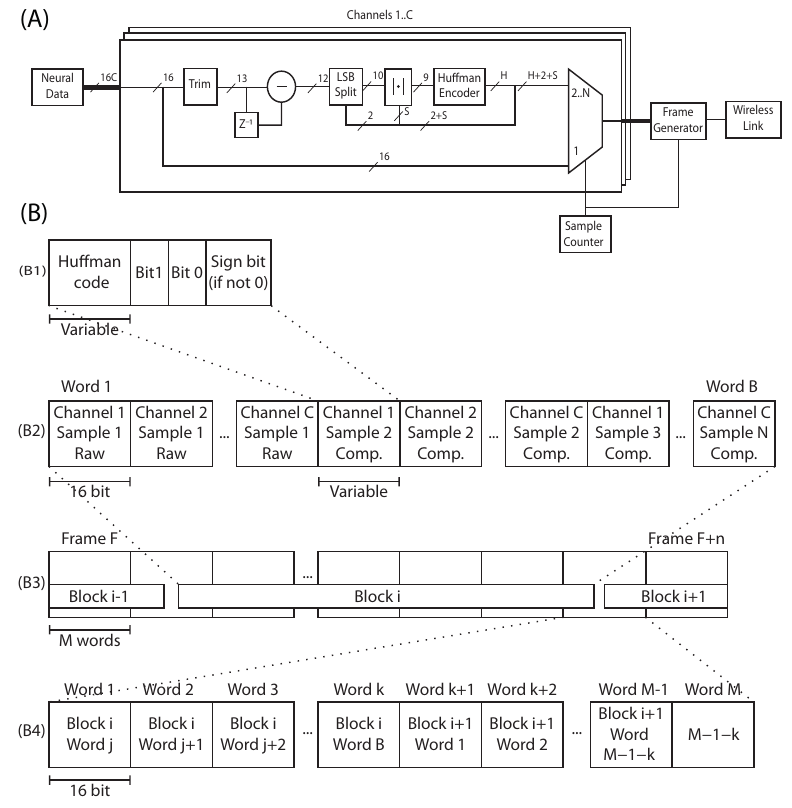
Figure 6. ( A ) Block diagram of the complete system, detailing the compression algorithm. H stands for the variable bit count of a Huffman-coded word, while S can be 1 bit for sign coding, or 0 bits for 0-value words. ( B ) Structure of the different protocols. ( B1 ): Compressed sample. ( B2 ): Compressed block of N samples for C channels. Total size of B word can vary depending on compression. ( B3 ): A block spans several frames, while a single frame can include the boundary between two blocks, ( B4 ): Frame of M words sent to the transmitter, with index to detect block